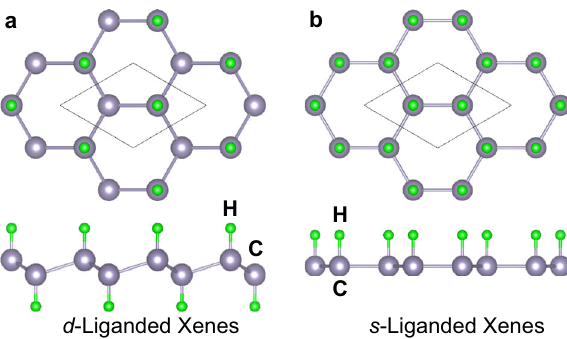
Fig. 1 Crystal structure of liganed Xene. a , b Crystal structure for double-side and single-side liganded Xenes (e.g., d -CH and s -CH) from the top (side) view [upper (lower)]. The gray and green spheres represent C and H atoms,